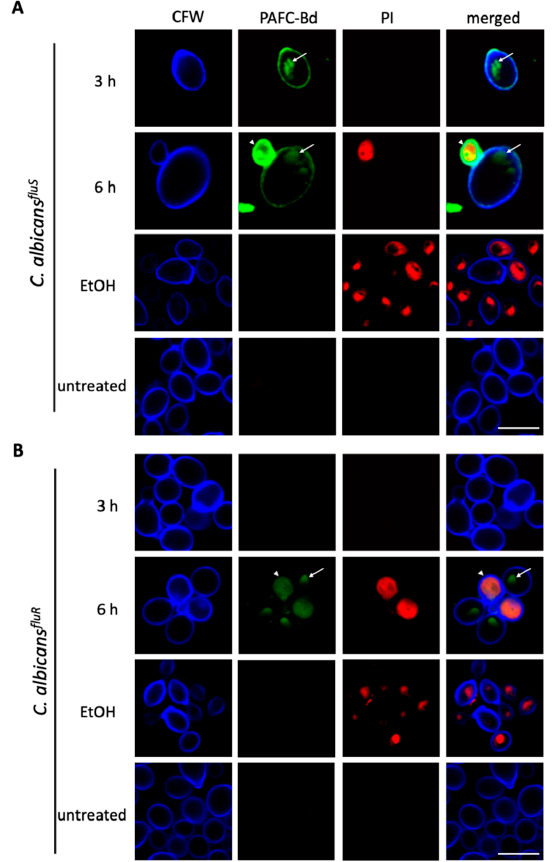
Figure 5. CLSM analysis of the cellular localization of PAFC and cell death induction. Cells of ( A ) C. albicans fluS and ( B ) C. albicans fluR were exposed to 1 × IC 90 PAFC-Bd (2.5 µ M) for 3 h, 6 h and 12 h and then stained with calcofluor white (CFW, 5 µ g mL − 1 ) and propidium iodide (PI, 5 µ g mL − 1 ) for 10 min. Control cells were left untreated. Sequential scanning was done for CFW (blue), PAFC-Bd (green) and PI (red) at 405, 488 and 543 nm, respectively. White arrows indicate vacuoles, white arrowheads dead cells. One representative image out of three replicates is shown. Scale bar, 5 µ